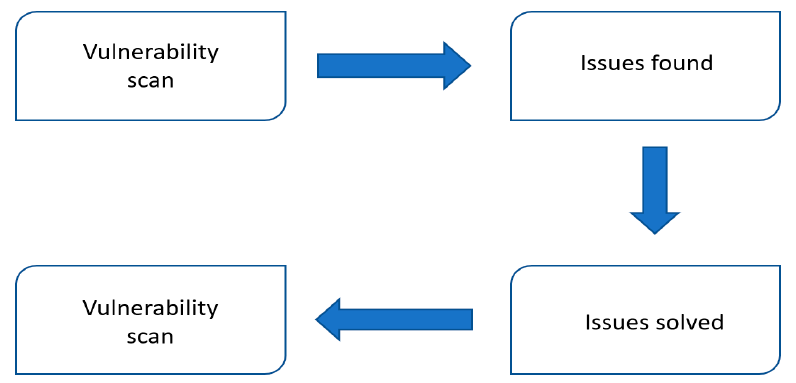
Figure 13. Security evaluation flow chart.